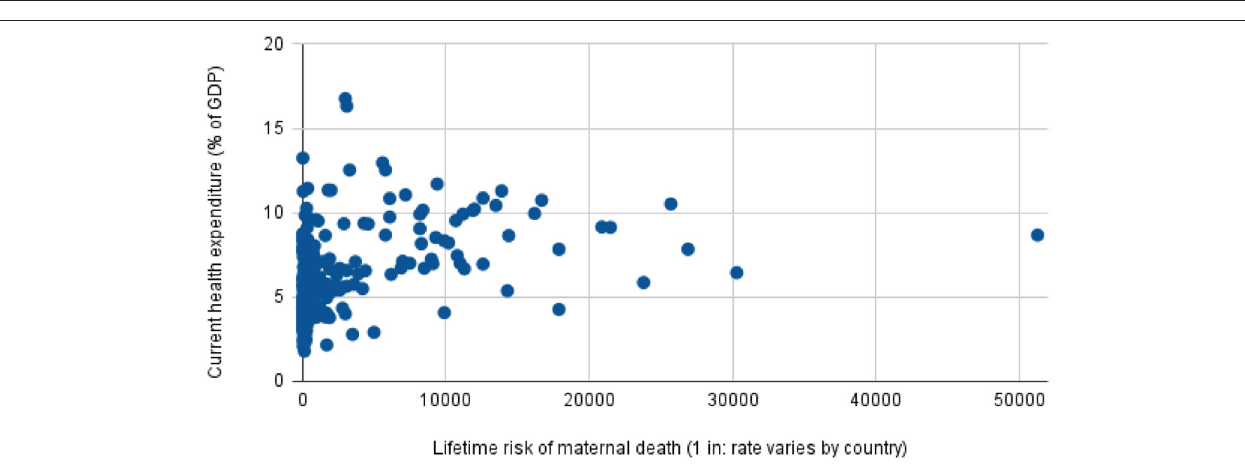
FIGURE 4 | Lifetime risk of maternal death: 1 in X, By income group. Source: WHO, UNICEF, UNFPA and the World Bank, Trends in Maternal Mortality: 2000 to 2017, WHO, Geneva, 2019. |UNICEF Data: Monitoring the situation of children and women.